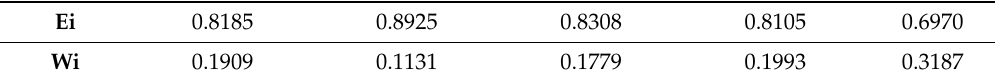
Table 6. Entropy coe ffi cient weight values.